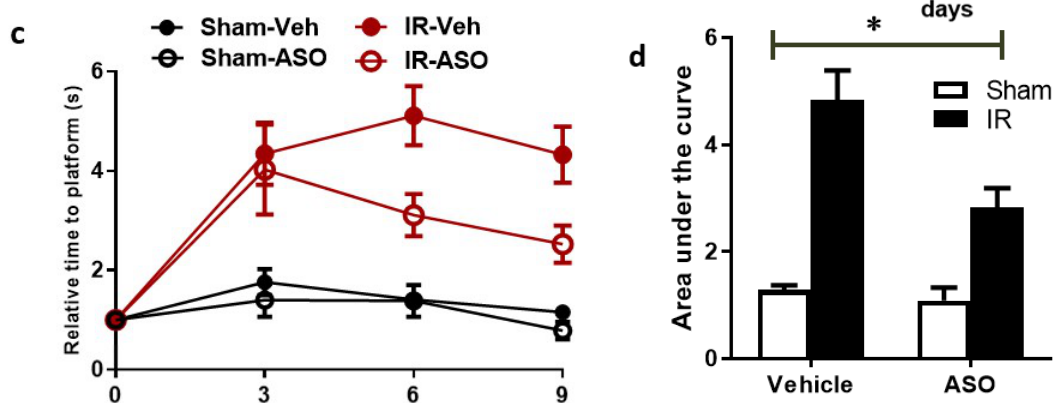
Figure 8. ( a , b ) Representative image and statistical analysis showing that transient ischemia increased number of acellular capillaries (marked with x), which was reduced by inhibiting TXNIP expression 2 days after IR. ( c , d ) I/R led to an increase in escape time, inhibiting TXNIP reduced the time to reach the platform 6 and 9 days after injury. ( n = 8–10, two-way ANOVA showed significant disease and treatment interaction, * P < 0.05 ASO vs IR vehicle).